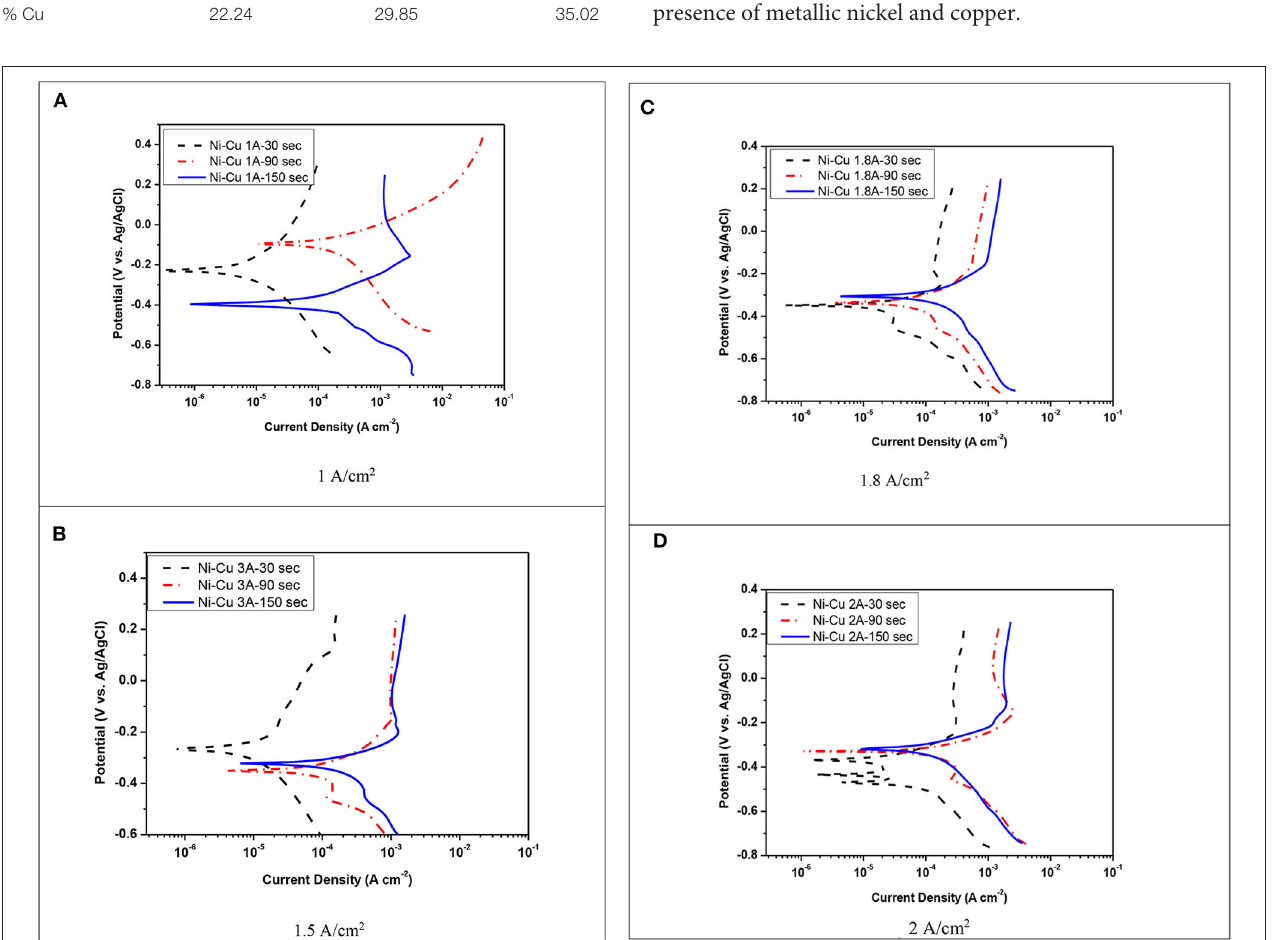
FIGURE 6 | Polarization curves for the corrosion of Ni–Cu foam in 1M KOH at 25 ◦ C. (A) 1 A/cm 2 , (B) 1.5 A/cm 2 , (C) 1.8 A/cm 2 , (D) 2 A/cm 2 .